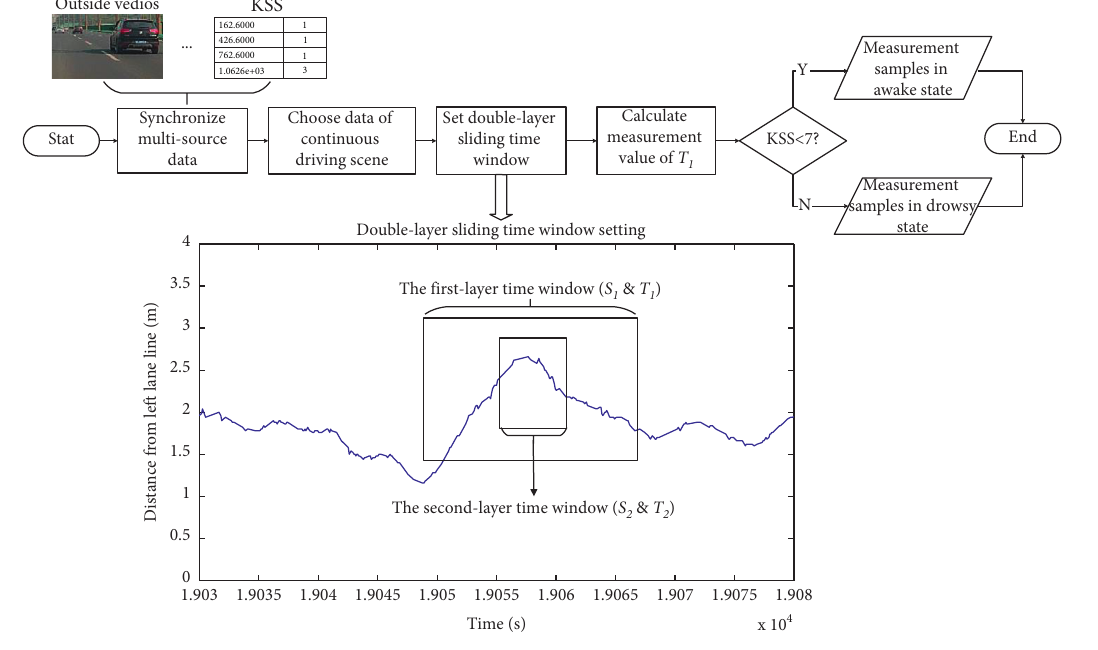
Figure 2: The workflow of data